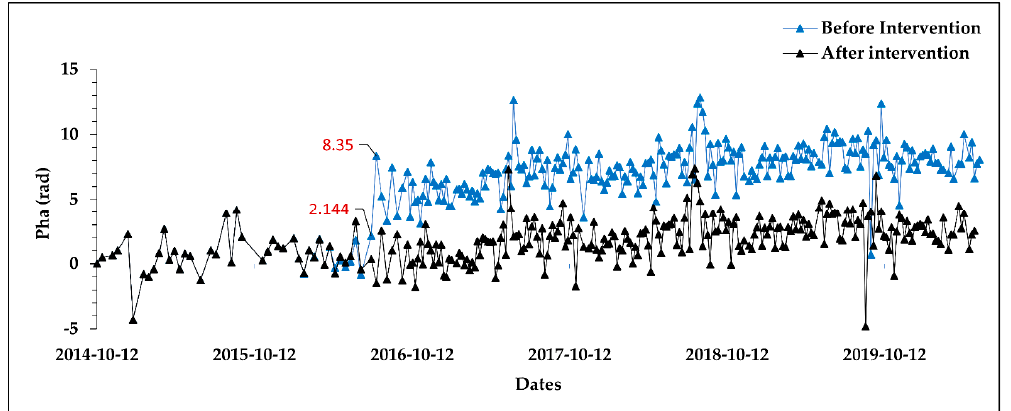
Figure 4. Improvement in the TS of phases of a PS before (in blue color) and after (in black color) excluding erroneous images. The images and the point were identified based on S im and S pt , respectively.